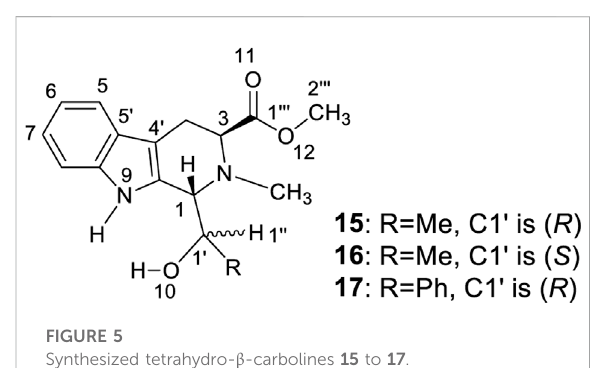
FIGURE 5 Synthesized tetrahydro- β -carbolines 15 to 17